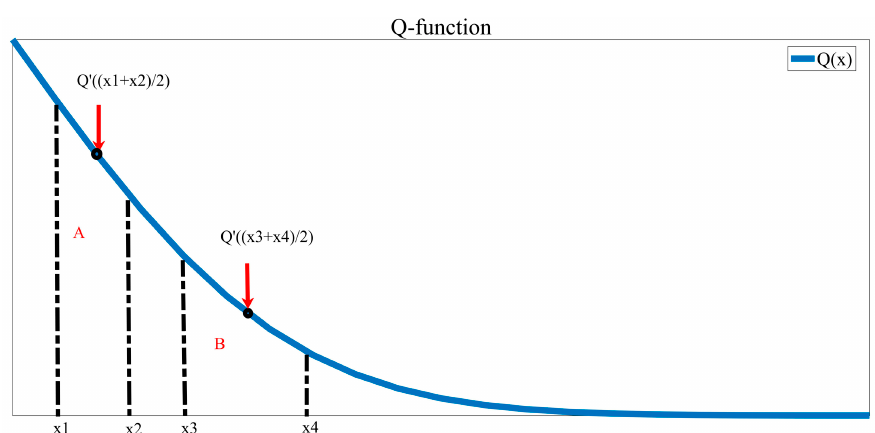
Figure A2. The diagram of A and B.